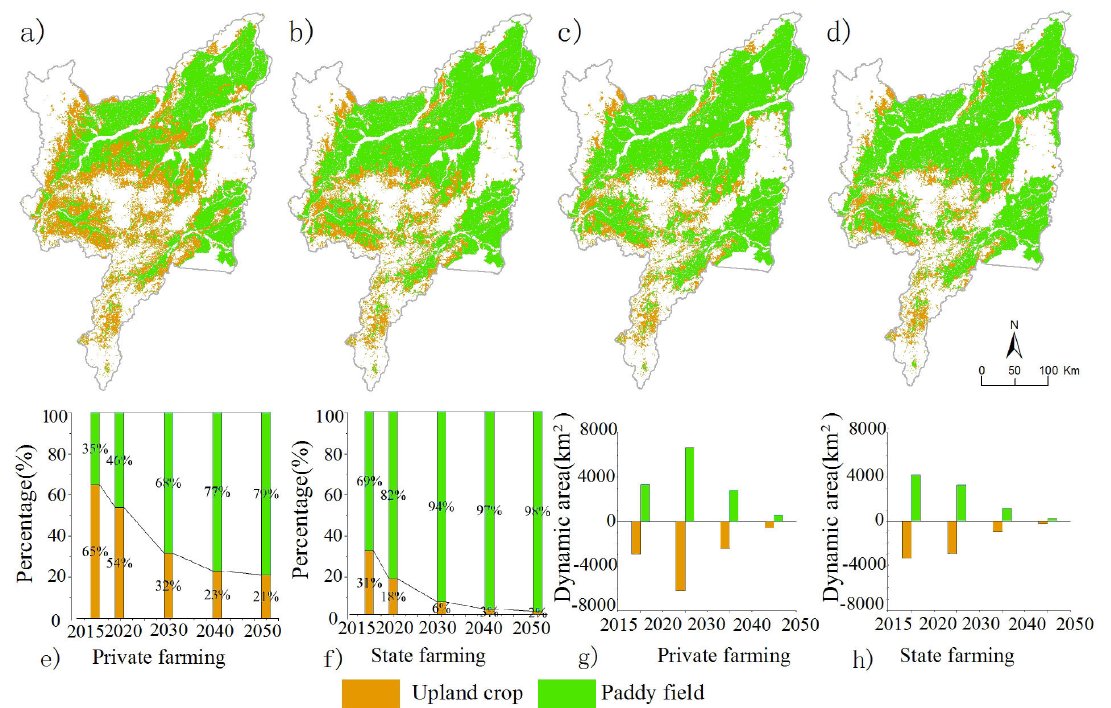
Figure 9. Resulting maps of the predicted cropping patterns and statistics. The predicted cropping patterns: ( a ): 2020; ( b ): 2030; ( c ): 2040; ( d ): 2050; statistics: ( e , f ): percentages of the upland crop and paddy field made up of cropland in private and state farming, ( g , h ): dynamic area of upland crop and paddy field in each period in private and state farming.